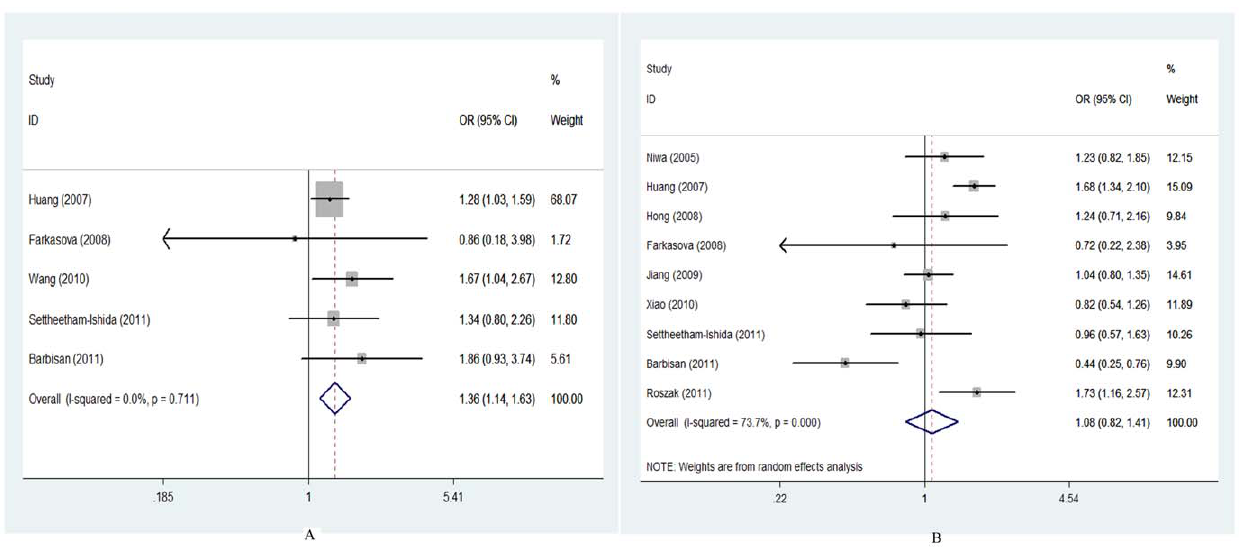
Figure 2. Forest plots of ORs with 95% CI for XRCC1 polymorphisms(Arg194Trp, Arg399Gln) and risk for cervical cancer. The center of each square represents the OR, the area of the square is the number of sample and thus the weight used in the meta-analysis, and the horizontal line indicates the 95%CI. (A) Arg194Trp, Trp/Trp + Trp/Arg vs. Arg/Arg. (B) Arg399Gln, Gln/Gln + Gln/Arg vs. Arg/Arg. doi:10.1371/journal.pone.0044441.g002 PLOS ONE |